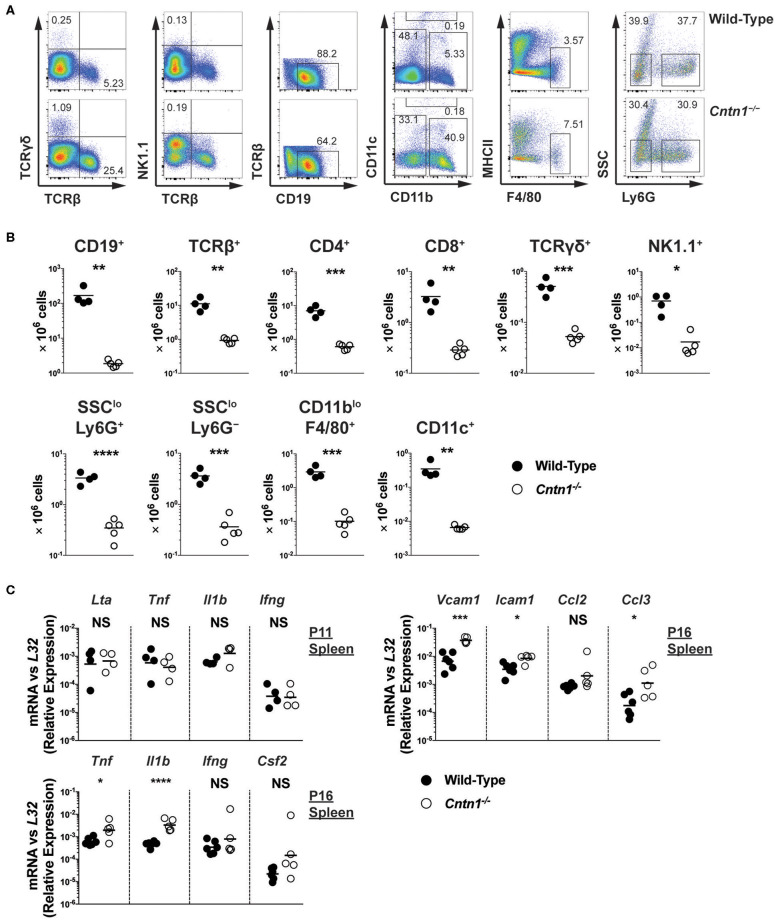
Hypocellularity and increased inflammatory signaling in Cntn1−/− spleens (A,B). Representative FACS analysis of wild-type (top) and Cntn1−/− (bottom) P16 spleens. Total live splenocytes analyzed for the frequency of αβ T cells (TCRβ+) and γδ T cells (TCRγδ+), natural killer cells (TCRβ−NK1.1+), TCRβ−TCRγδ− cells for the frequency of B cells (CD19+), TCRβ−NK1.1− cells for the frequency of dendritic cells (CD11chi), TCRβ−NK1.1−CD11c−CD11blo cells for the frequency of macrophages (F4/80+MHCIIlo), and TCRβ−NK1.1−CD11c−CD11bhi cells for the frequency of neutrophils (Ly6G+SSClo) and monocyte containing populations (Ly6G−SSClo) (A). Lineage gating was structured according to previously reported analysis (24). The frequency of individual splenocyte populations are graphed in (B). Analysis of data by Student's t-test (C). P11 and P16 splenic tissue from wild-type and Cntn1−/− animals was harvested for RNA and analyzed for the indicated genes by QRT-PCR. Graphs show transcript abundance relative to L32. Individual transcripts were compared by Student's t-test. NS, not significant; *p < 0.05; **p < 0.01; ***p < 0.001; ****p < 0.0001.